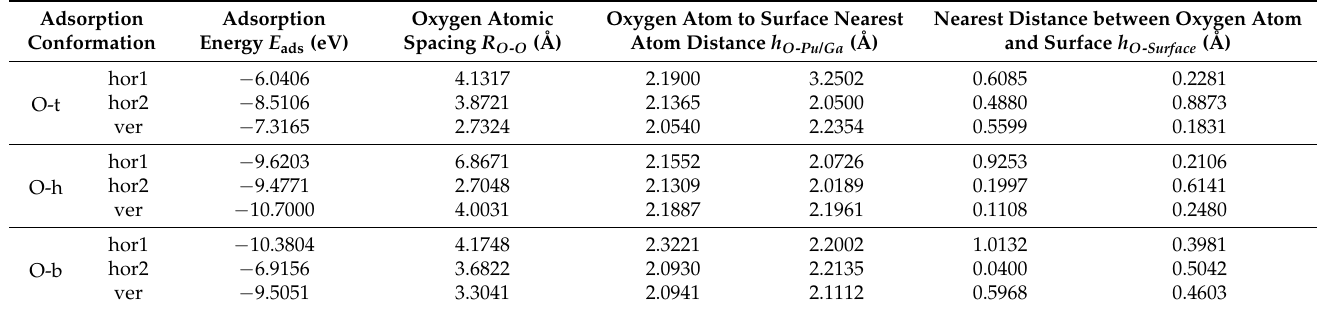
Table 1. Structural parameters and energy data of the adsorption configuration of O 2 on the surface of the plutonium gallium system.